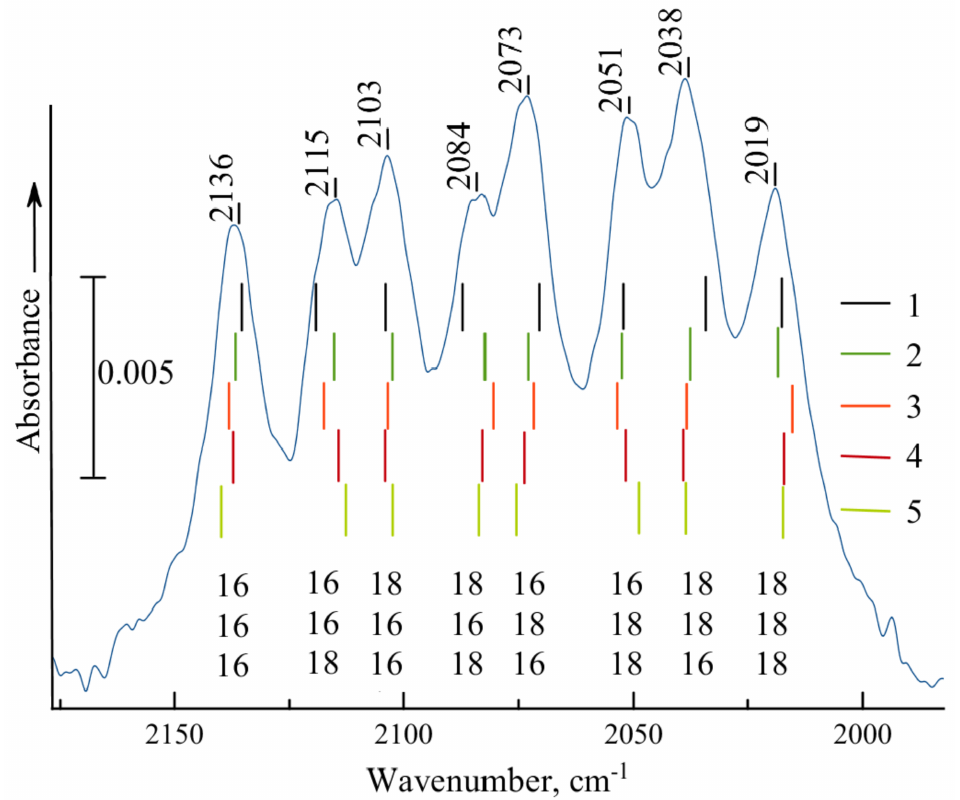
Figure 1. Experimental spectrum of a 50% 18 O isotopic mixture of ozone chemisorbed on TiO 2 (solid curve) and the calculated frequencies of the ν 1+3 combination mode of 8 ozone isotopomers forming a monodentate complex with the TiO 2 cluster ( 1 ), with 5- ( 2 ) and 4-coordinated ( 3 ) Ti 4+ ions of the Ti 20 O 40 cluster, and bidentate complexes with 5- ( 4 ) and 4-coordinated ( 5 ) Ti 4+ sites of the same Ti 20 O 40 cluster. The values 16 or 18 under the bands denote the positions of isotopic atoms in the ozone molecule: the lower index corresponds to the oxygen atom nearest the Ti 4+ cation. To provide the coincidence of the mean positions of the band of different species, the calculated values were multiplied by the following scaling factors: 0.9698, 0.8961, 0.9002, 0.9128, and 0.9107, for 1–5,